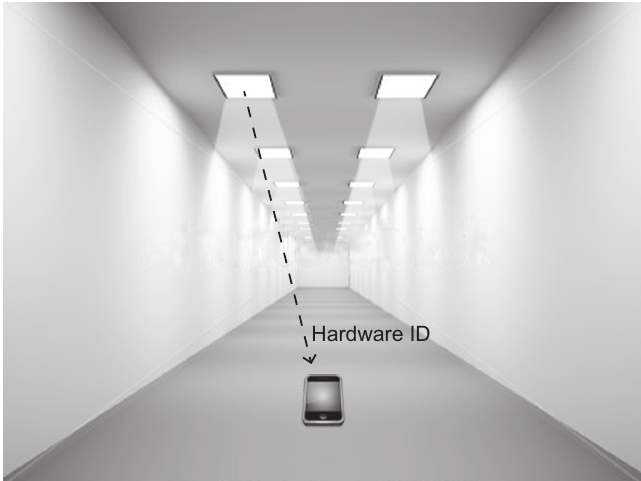
Figure 1. A model of indoor visible light communication (VLC) based